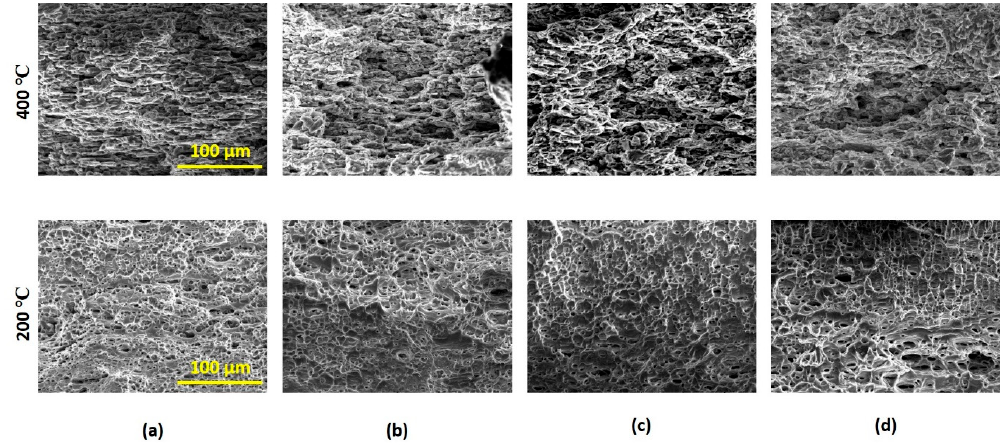
Figure 7. Fracture surfaces of ( a ) as-received (AA7075-T6 aluminum alloy), ( b ) the solution heat-treated condition, ( c ) the sample processed in a die with a temperature of 24 °C, and ( d ) the sample processed in a die with a temperature of 350 °C after tensile tests at the strain rate of 0.01 s − 1 and temperatures of 200 °C and 400 °C.